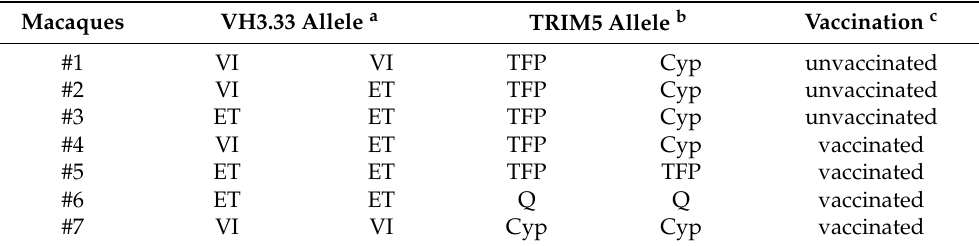
Table 2. Burmese rhesus macaques used for analysis of NAb induction after SIVsmE543-3 infection. Macaques VH3.33 Allele a